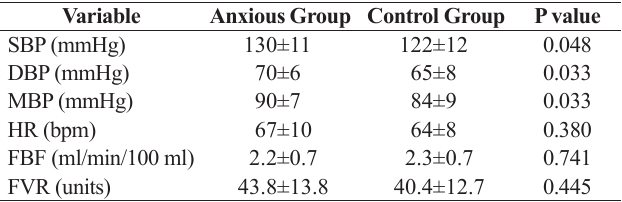
Table 2. Hemodynamic Characteristics at